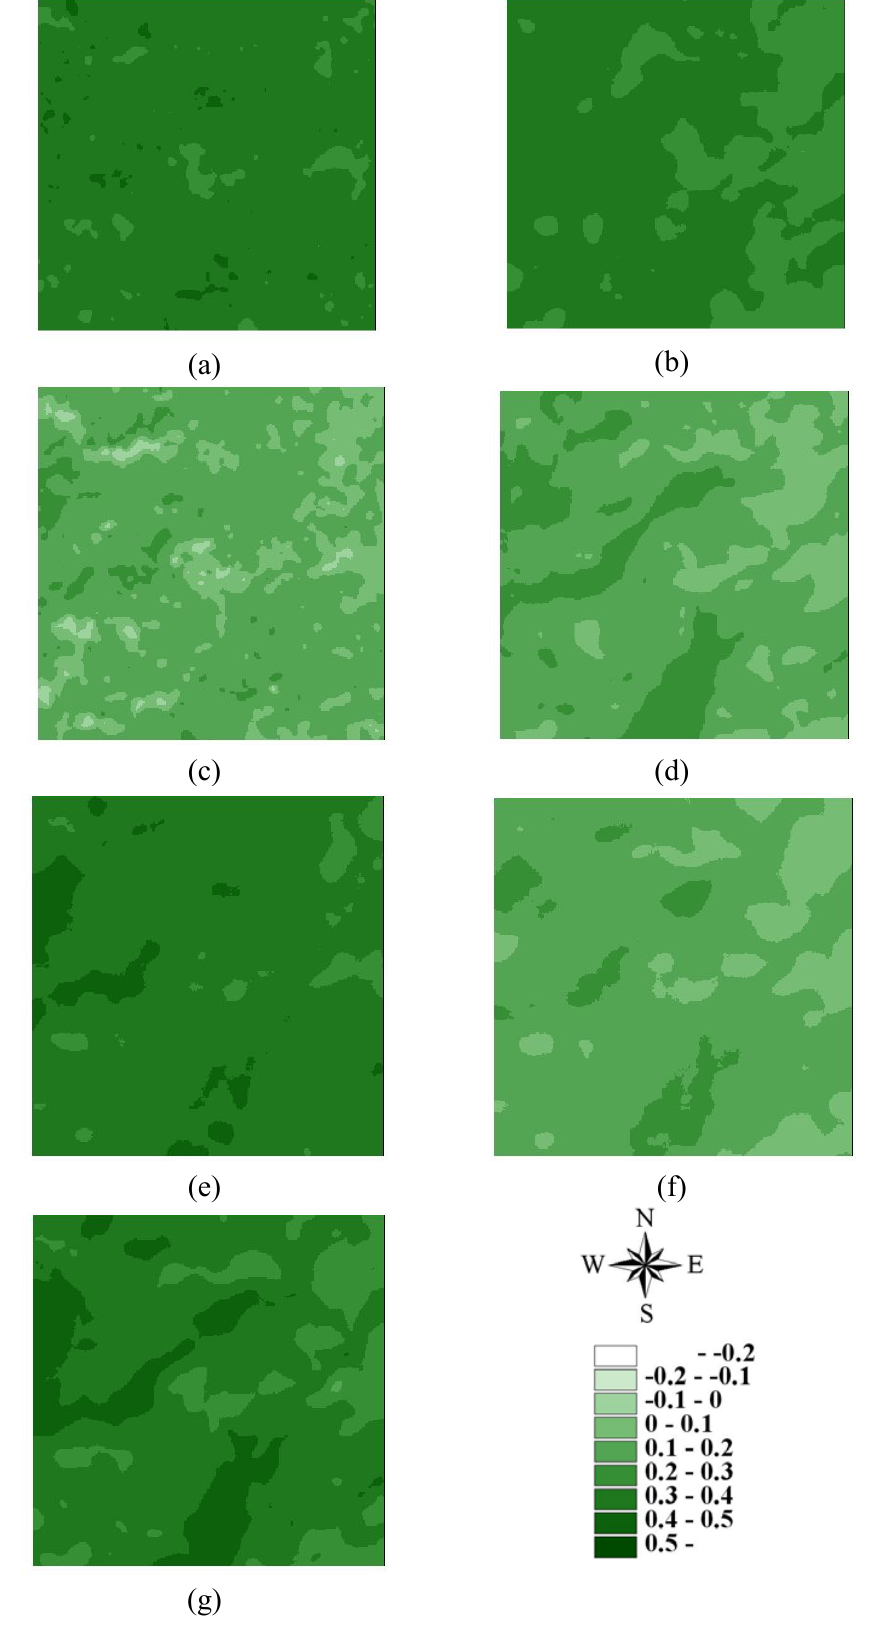
Figure 10. NDVI images estimated by kriging based on 3,000 samples in area B on (a) 1996/11/08, (b) 1999/03/06, (c) 1999/10/31, (d) 2000/11/27, (e) 2001/11/20, (f) 2003/12/17, and (g)